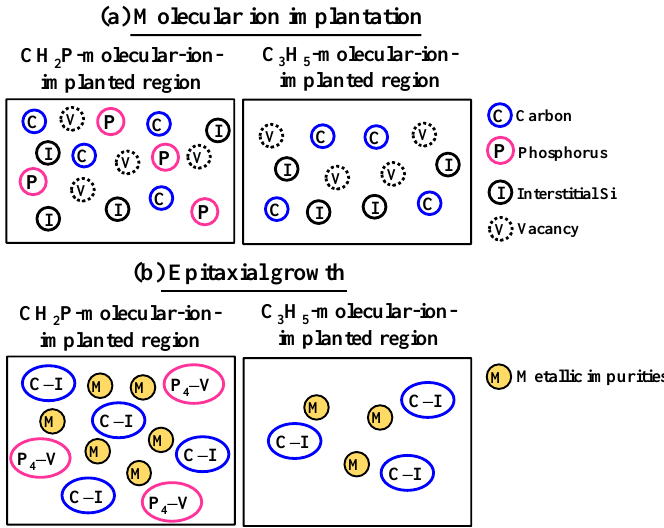
Figure 13. Illustration of formation model of each complex in CH 2 P- and C 3 H 5 -molecular-ion-im- planted regions during ( a ) molecular ion implantation and ( b ) epitaxial growth.